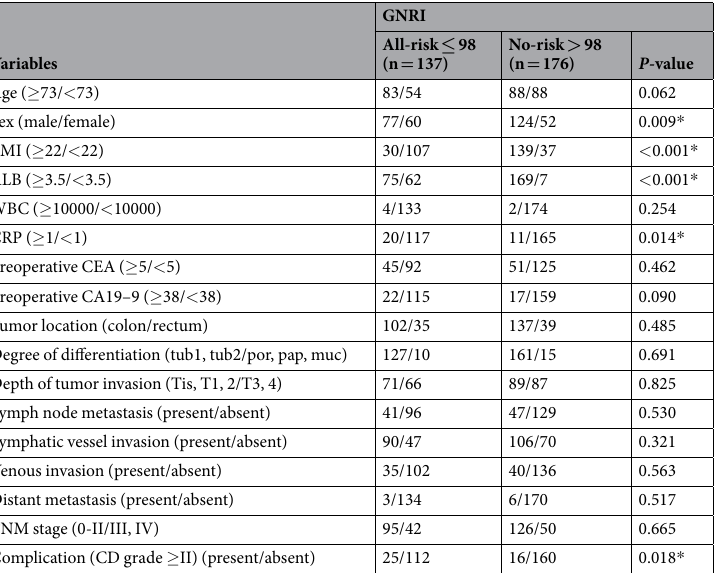
Table 2. The relationship between GNRI status and clinicopathological factors in the elderly patients with CRC. GNRI = geriatric nutritional risk index, CRC = colorectal cancer, BMI = body mass index, ALB = serum albumin, WBC = white blood cell, CRP = C-reactive protein, CEA = carcinoembryonic antigen, CA19–9 = carbohydrate antigen 19–9, tub1 = well differentiated adenocarcinoma, tub2 = moderately differentiated adenocarcinoma, por = poorly differentiated adenocarcinoma, pap = papillary adenocarcinoma, muc = mucinous adenocarcinoma, TNM = tumor-node-metastasis, CD = Clavien-Dindo, Asterisk values indicate P-values <